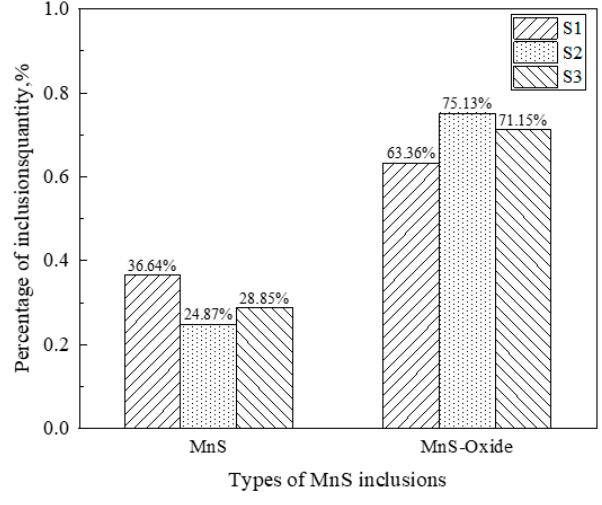
Figure 4. Types and percentage of sulfides in samples.